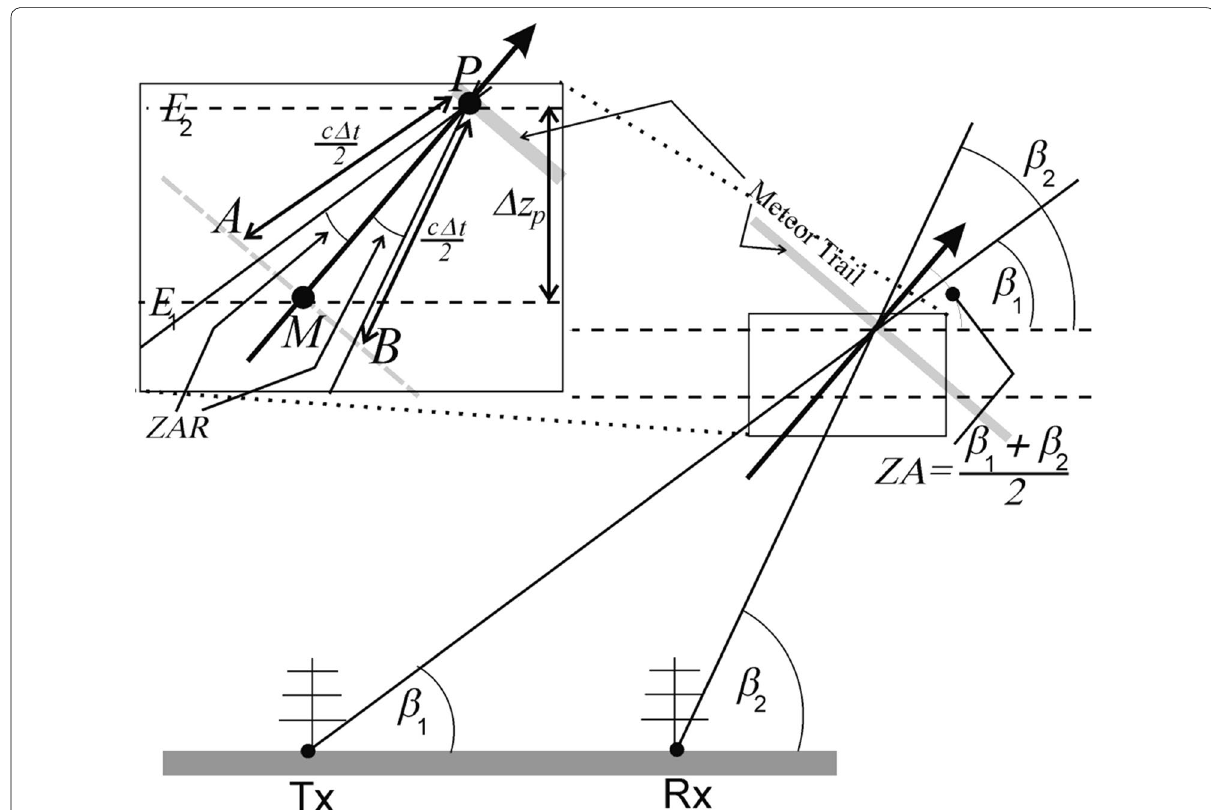
Fig. 2 Orientation of a meteor trail, and path lines of ray vectors, for a general meteor. The radio pulse travels from the transmitter to the meteor trail and back to the receiver on the left. Note that only one receiver is drawn—normally there are more (typically 5) at separations of only one or two wavelengths from each